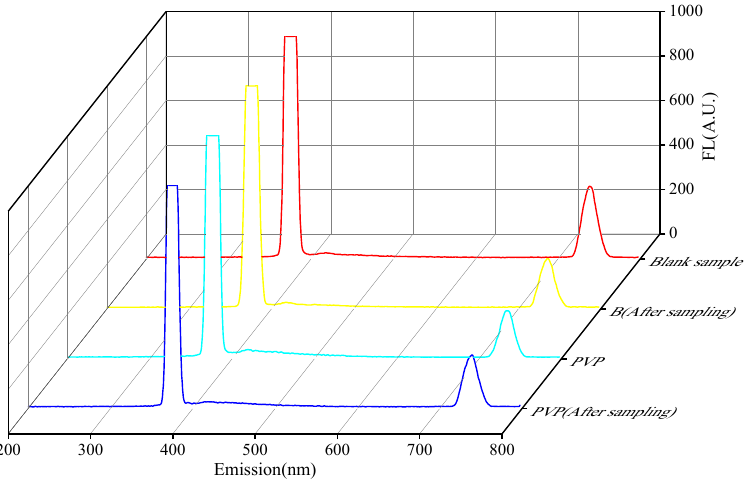
Figure 4 . Fluorescence comparison between glass fiber membrane and PVP membrane before and after sampling.